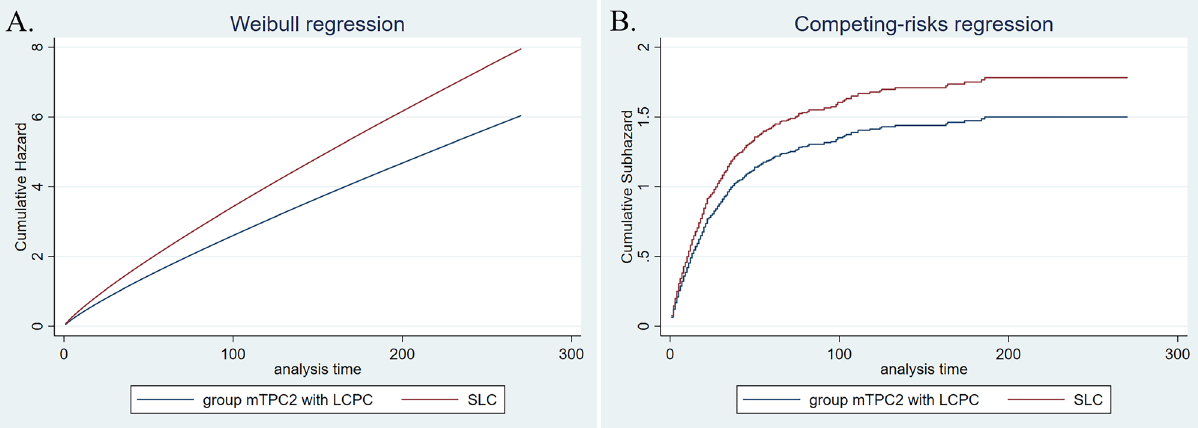
Figure 4. Adjusted cumulative hazard of all-cause death ( A ) and cancer-specific death ( B ) in mTPC2 group with PCLC and matched single lung